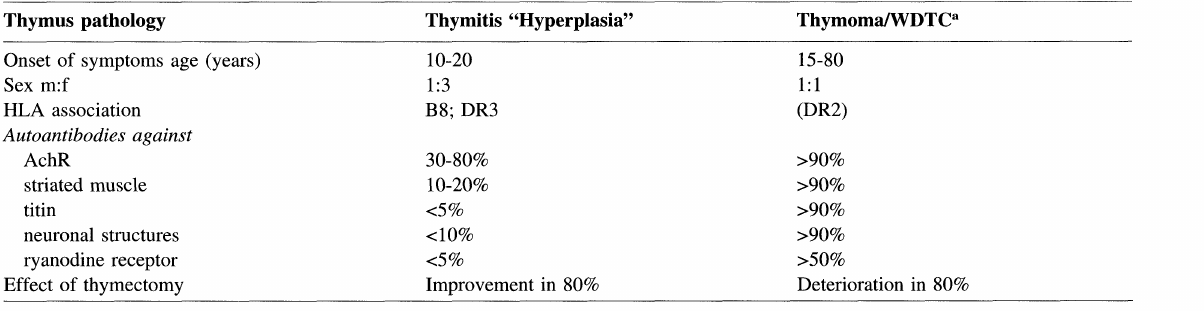
TABLE III MG Subtypes According to Thymus Pathology: Correlation with Clinical and Epidemiological Findings. MG with Neither Thymitis nor TET Exhibits an Age-Related thymus